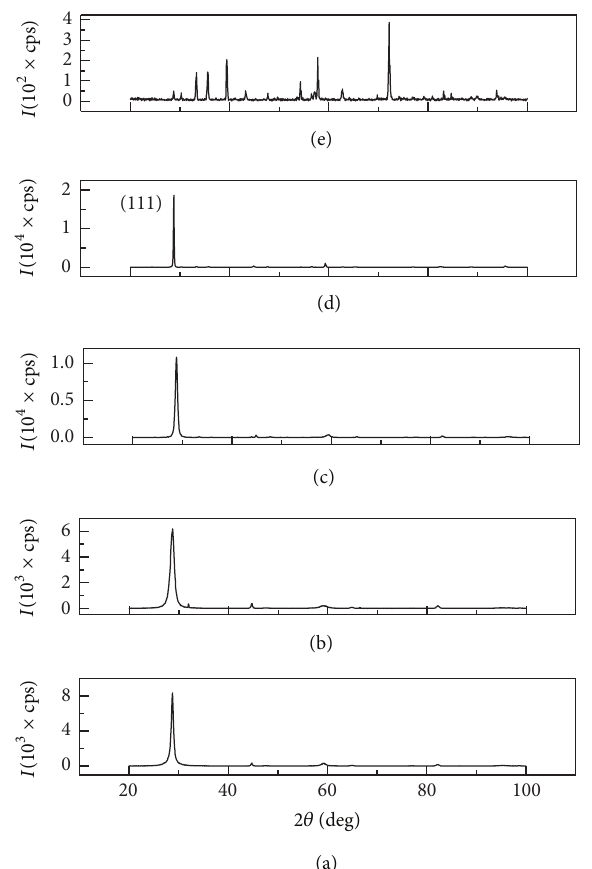
Figure 8: The XRD patterns for cerium oxide films electrodeposited in galvanostatic mode: j = − 0.06 mA/cm 2 , T = 80 ∘ C. (a) unsintered and sintered at temperatures of (b) 300 ∘ C, (c) 500 ∘ C, (d) 900 ∘ C, and (e) 1100 ∘ C.